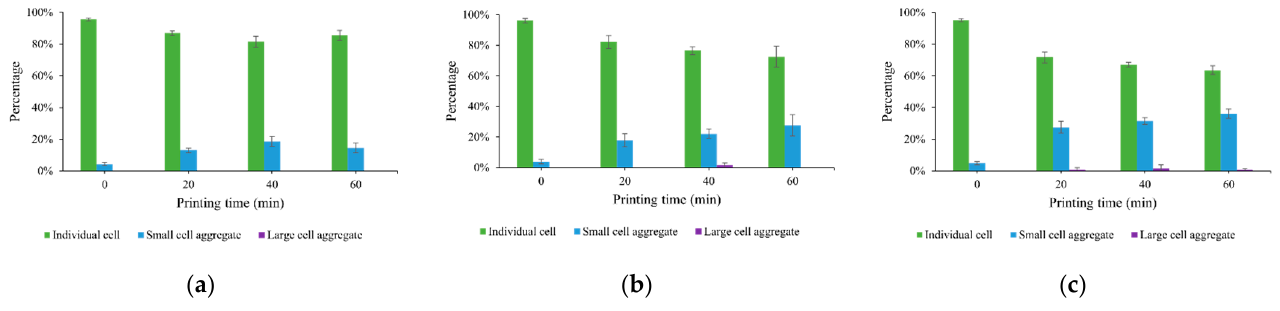
Figure 6. Cell existing forms at the bottom of the bioink reservoir using the bioink composed of 1.5% ( w / v ) sodium alginate and a cell concentration of ( a ) 1 × 10 6 cells/mL, ( b ) 1.5 × 10 6 cells/mL, and ( c ) 2 × 10 6 cells/mL.